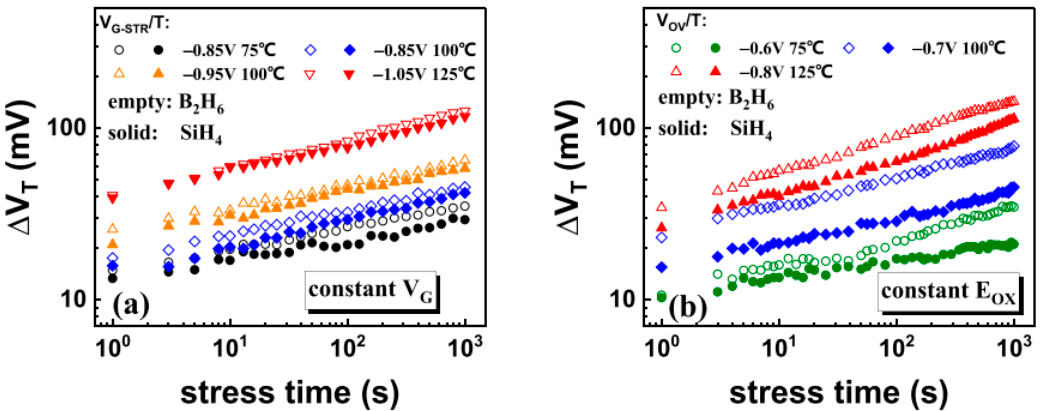
Figure 42. Threshold voltage shift ( Δ V T ) kinetics at different gate V G-STR and T under constant V G stress for ALD W using B 2 H 6 and SiH 4 . ( a ) Under constant V G stress; ( b ) under constant E OX stress. The SiH 4 -based devices shows reduced negative bias temperature instability (NBTI) degradation than B 2 H 6 -based devices under both constant V G and constant E OX stress [295].